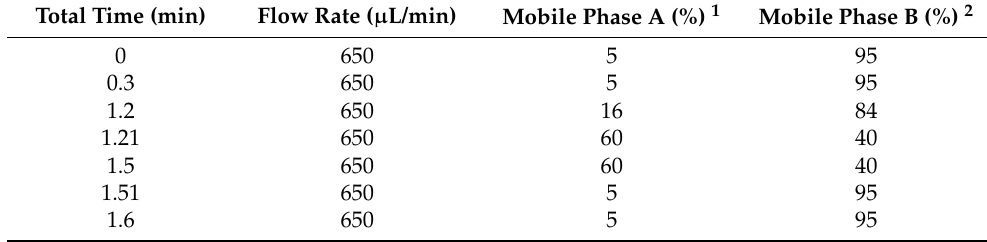
Table 2. Elution gradient used for BEH Hilic column for polyols quantification. Total Time (min) Flow Rate ( µ